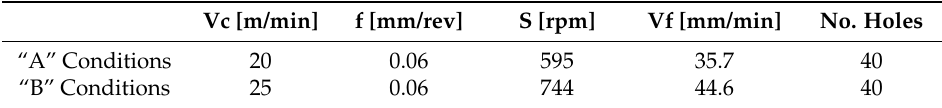
Table 2. Conditions used for drilling in Inconel 718.